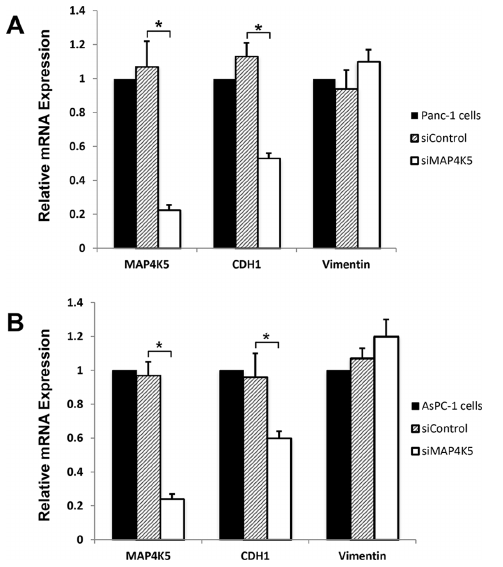
Fig 5. Knockdown MAP4K5 expression leads to decreased expression of E-cadherin mRNA, but no significant changes in the expression of vimentin mRNA in Panc-1 (A) and AsPC-1 cells (B). * P < 0.01.